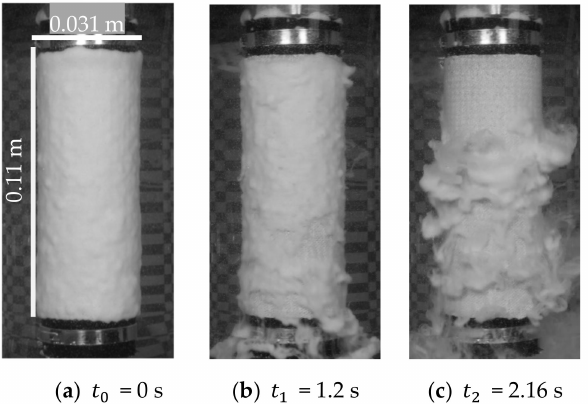
Figure 7. Backwashing behavior of the pure C1 layer with a surface loading of 0.13 kg · m − 2 and the resulting cake height of 0.7 mm.